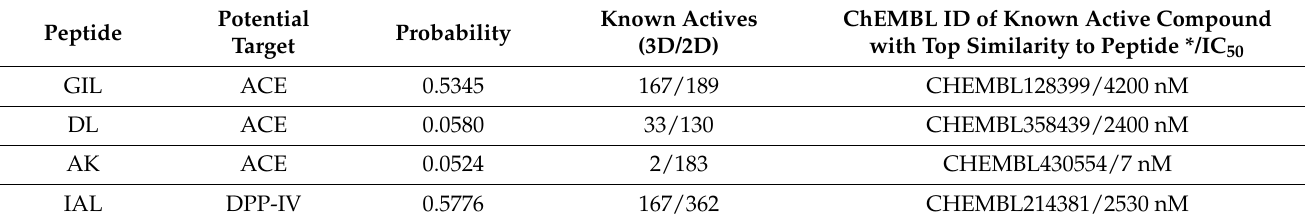
Table 4. Peptide sequences having ACE or DPP-IV as potential target as predicted by SwissTargetPre-